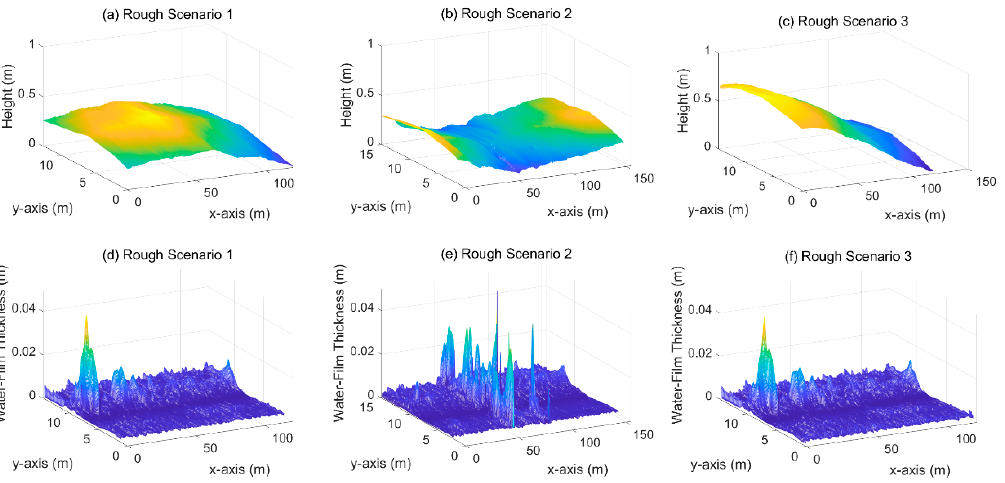
Figure 15. Water-film estimation results on rough road surfaces.( a–c ): 3D road surface of rough scenario 1~3; ( d – f ): water-film thickness distribution of rough scenario